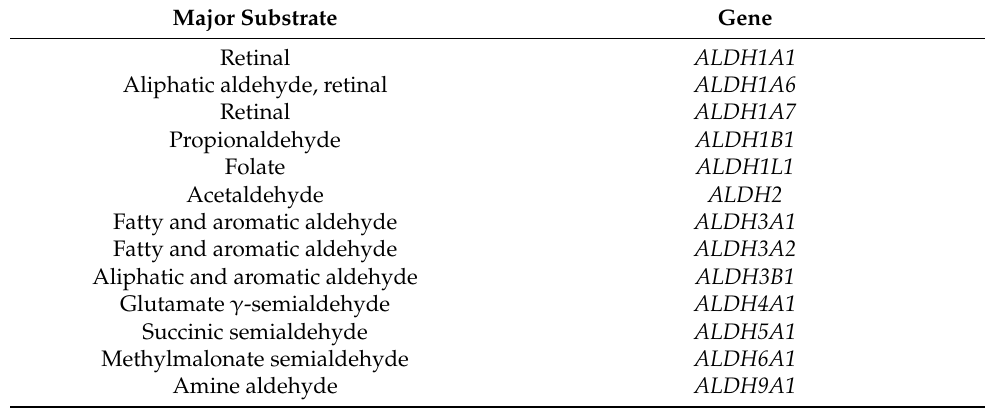
Table 2. Human ALDH polymorphisms b